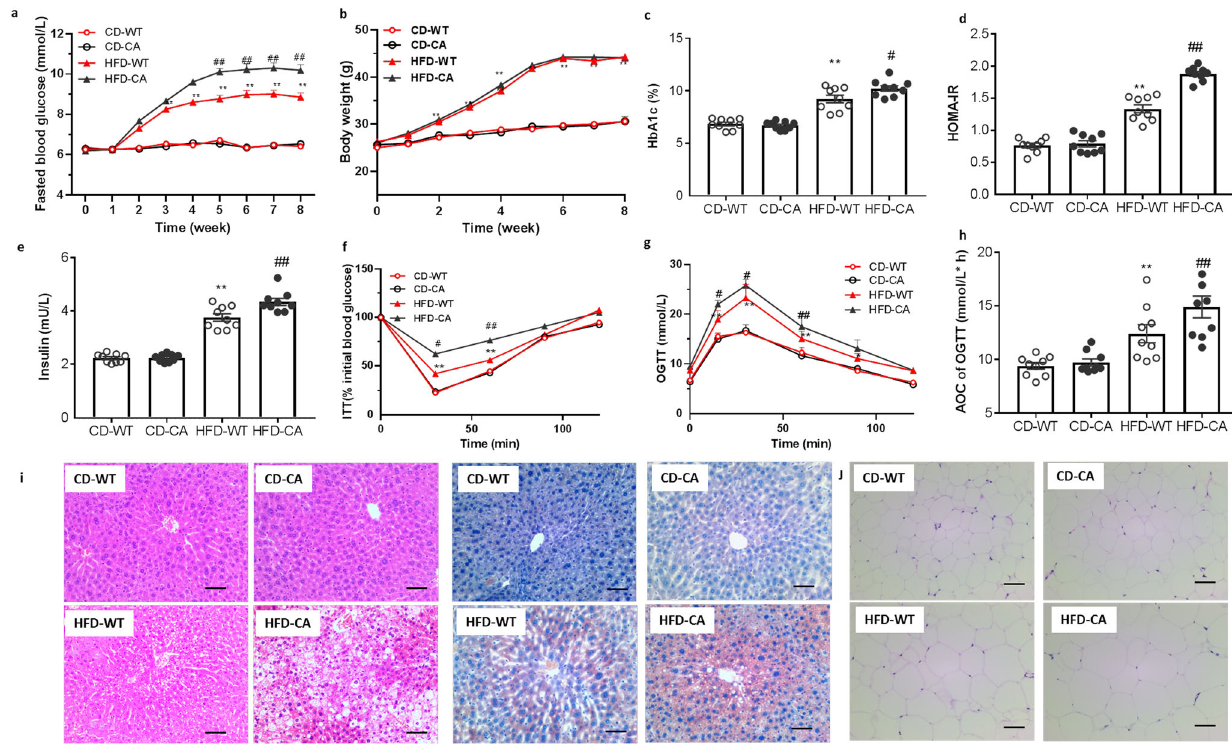
Fig. 3 Effects of C. albicans strains isolated from T2DM patients on the induction of insulin resistance. In both CD fed and HFD fed mice. a fasted blood glucose, b Body weight, c HbA1c, d HOMA-IR, e insulin level, f ITT on the 29th day, g OGTT, and h AOC on the 36th day of treatment, i representative images of H & E-stain, oil-red stain of liver tissue, and j representative images of H & E-stain of adipose tissue, Scale bars = 100 μ m ( n = 3 mice per group). Data are presented as the mean ± standard error of the mean (SEM); n = 9 mice per group. Statistical analysis was done using one-way ANOVA followed by the Tukey post hoc test. * P < 0.05; ** P < 0.01 vs CD-WT group, and # P < 0.05; ## P < 0.01 vs HFD-WT group.